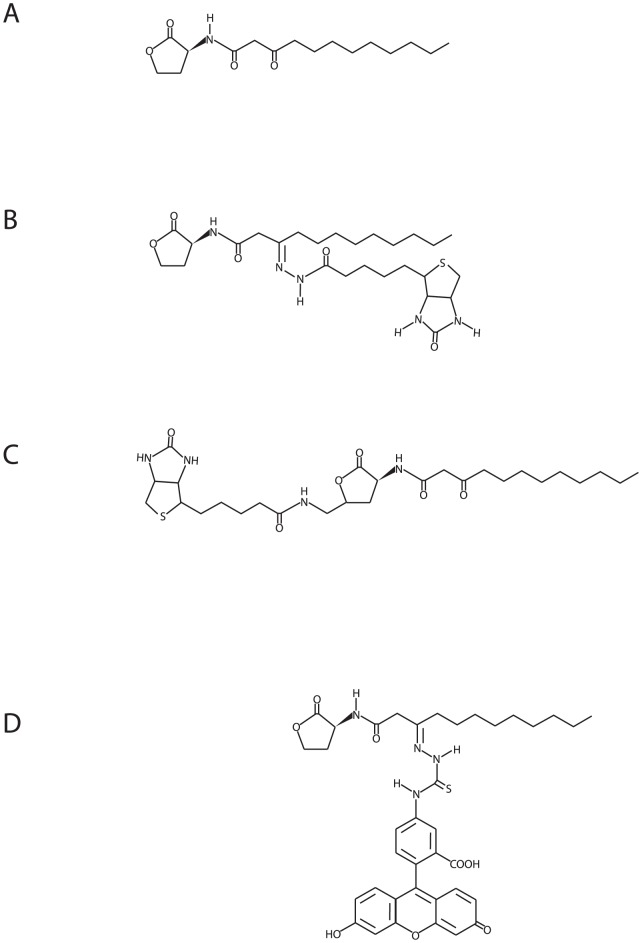
Synthetic AHL molecules used in this study.(A) N-3-oxo-dodecanoyl-L-homoserine lactone C16H27NO4, MW 297.4 (3O-C12-HSL) which is structurally and functionally identical to those obtained from P. aeruginosa cultures; (B) biotin-conjugated probe N-dodecanoyl-L-homoserine lactone-3-hydrazone-biotin C26H43N5O5S, MW 537.7 (3O-C12-HSL-3H-biotin) and (C) N-dodecanoyl-L-homoserine lactone-biotin C38H41N3O9S, MW 552.7 (3O-C12-HSL-biotin); (D) Fluorescently-tagged probe N-dodecanoyl-L-homoserine lactone-3-hydrazone-fluorescein, C37H40N4O8S, MW 700.8 (3O-C12-HSL-FITC).